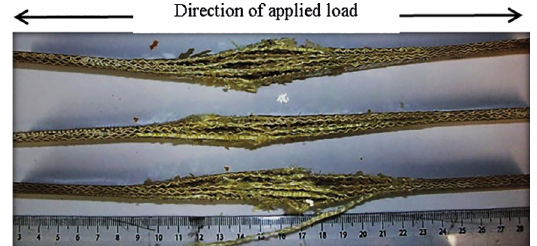
Figura 7. Fracture characteristic - HFCL laminate - uniaxial tensile.